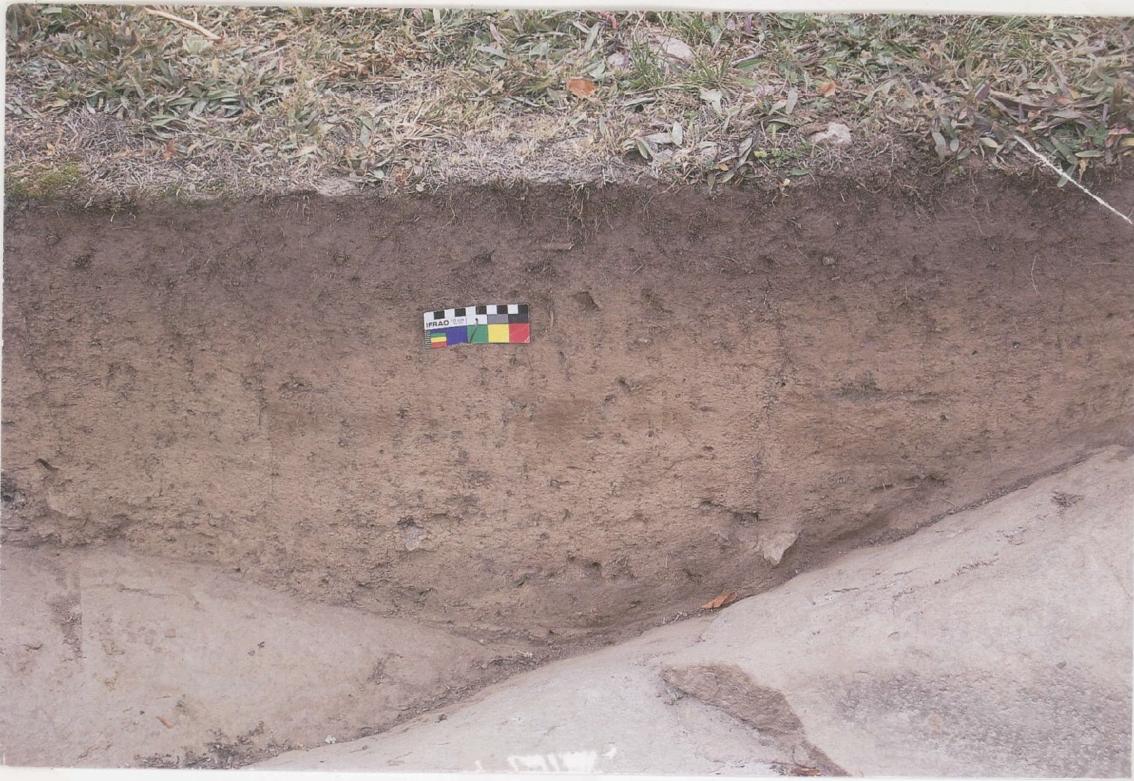
Figure 6. Exceptionally deep deposit of loess, the oldest soil horizon on the Hensler Site. This zone is highly productive and contains the typologically oldest artifacts. Photo by